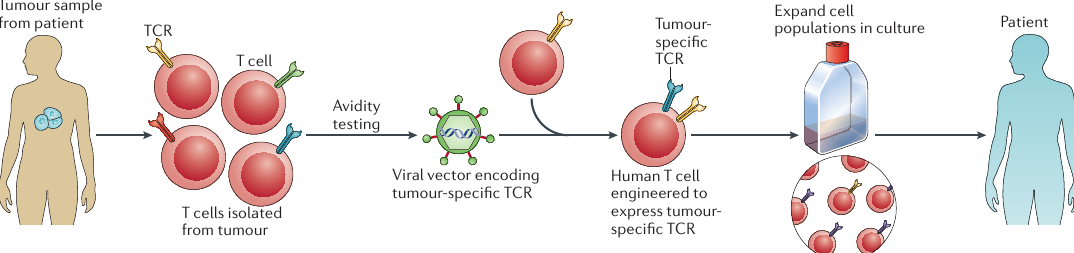
Figure 2. Adoptive cell transfer. T cells can be genetically engineered to recognize tumor-associated antigens in various ways. If a patient expresses a tumor-associated antigen (TAA) that is recognized by an available receptor structure, autologous T cells can be genetically engineered to express the desired receptor. New receptors can be generated in a variety of ways. T cells can be identified and cloned from patients with particularly good antitumor responses. Their T cell receptors (TCRs) can be cloned and inserted into retroviruses or lentiviruses, which are then used to infect autologous T cells from the patient to be treated. Reproduced with permission from NPG with modifications